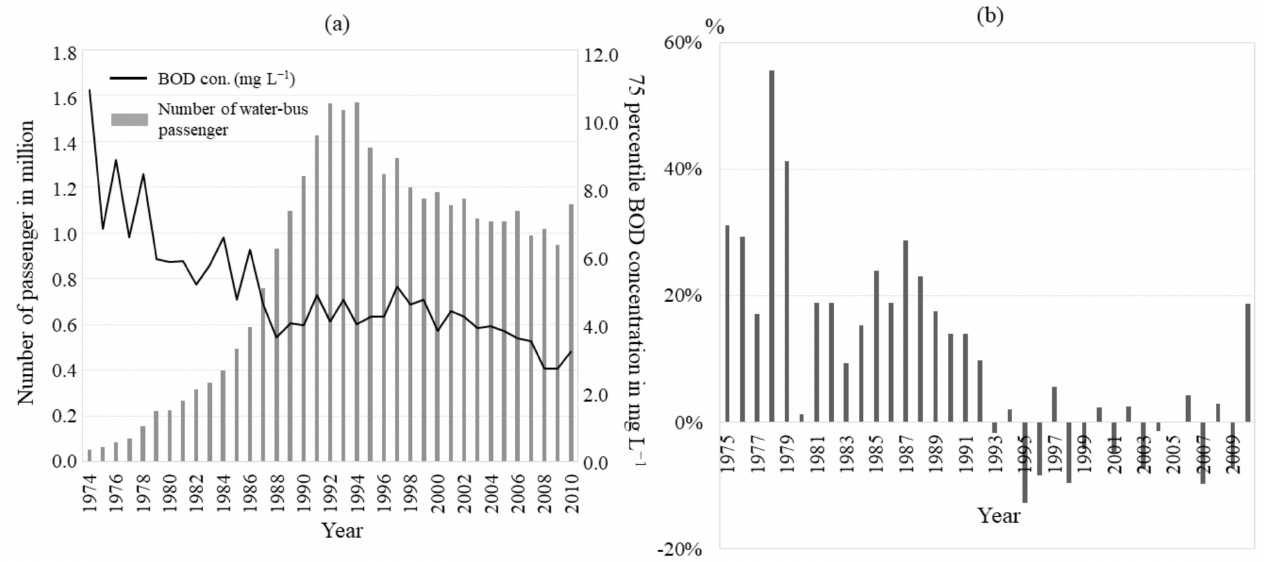
Figure 7. ( a ) Number of water-bus passenger and BOD con. in mg L − 1 . ( b ) Growth in the number of passengers in